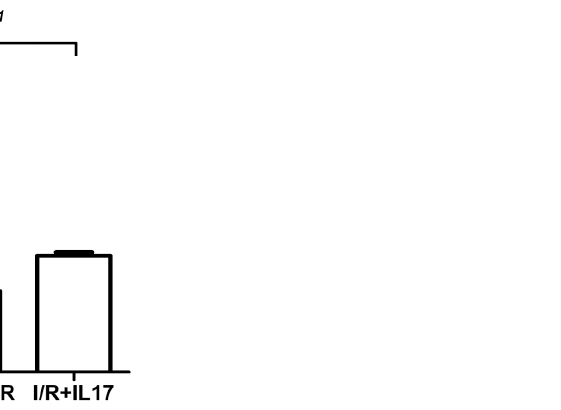
Figure 2. Liver biochemistry for MDA reflects the significant effect of both anti-inflammatory pretreatments in reducing I/R-induced injury. Numbers on the Y-axis of the bar graph correspond to the mean ± SEM of MDA concentration. *** p < 0.001.